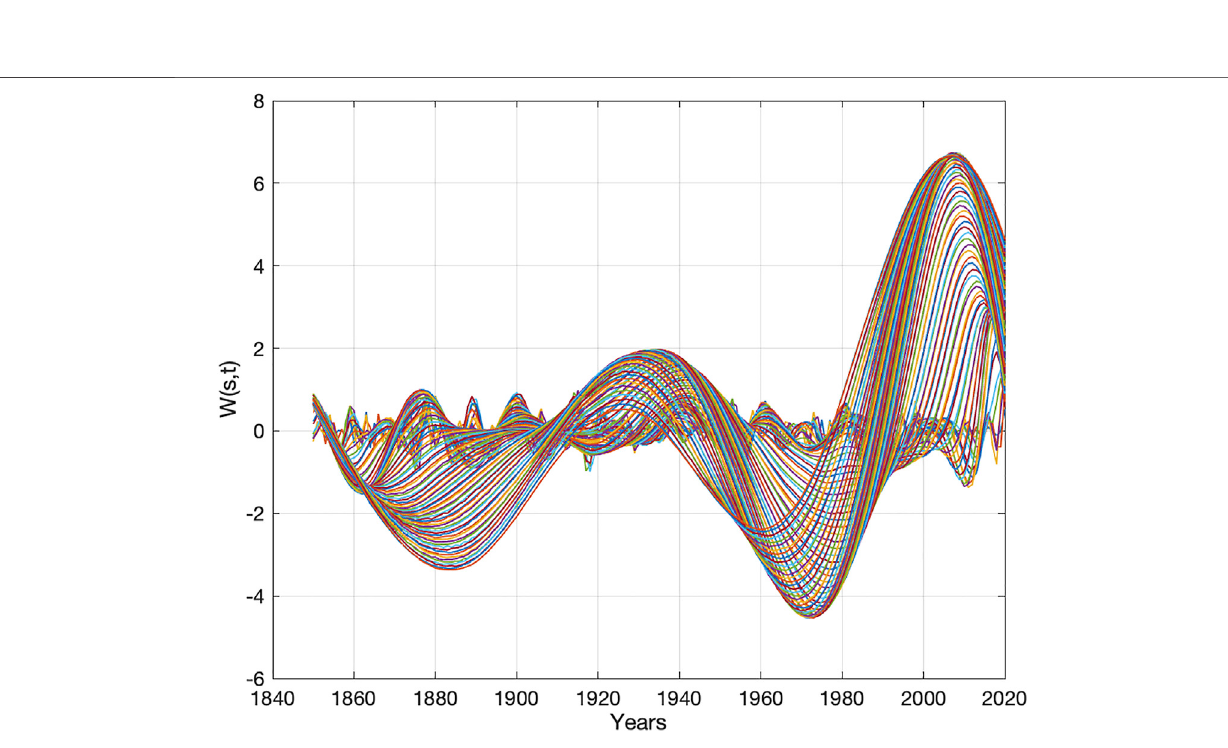
Frontiers in Astronomy and Space Sciences |